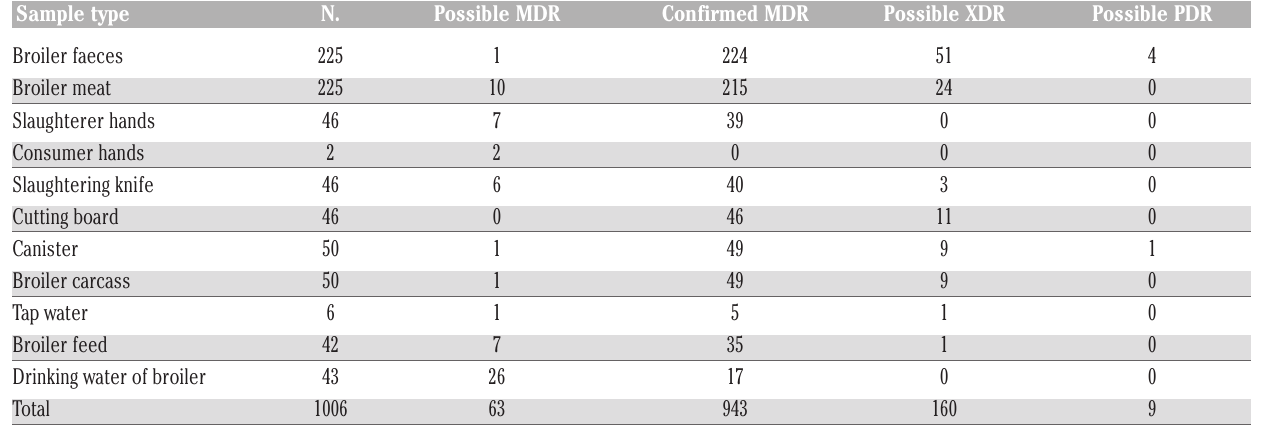
Table 4. Distribution of multidrug resistant (MDR), extensively drug-resistant (XDR) and pandrug-resistant (PDR) Escherichia coli in various sample types. Sample